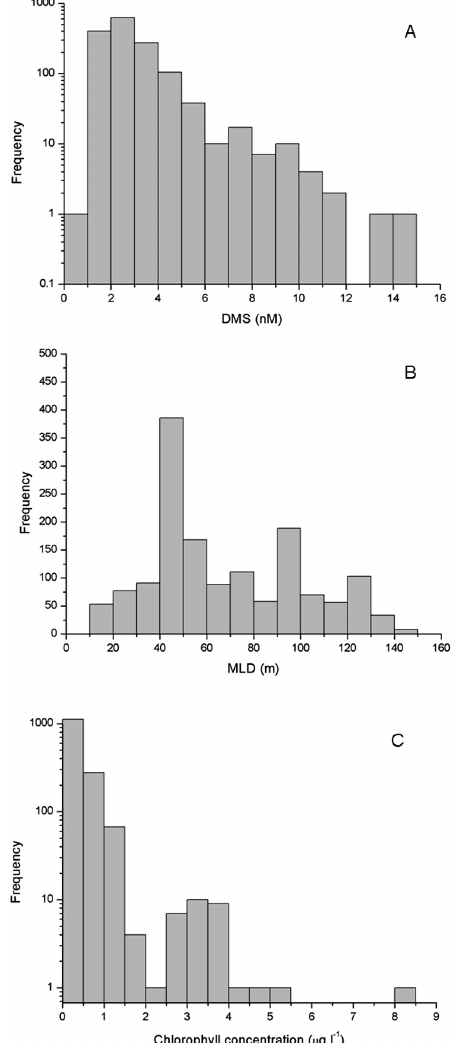
Fig. 2. Frequency plots of measured DMS (Panel A), mixed layer depth (MLD) (Panel B) and chlorophyll (Panel C).